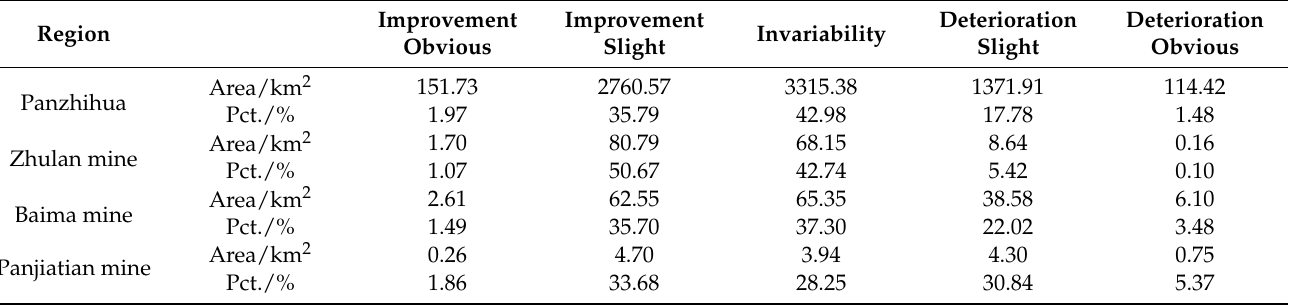
Table 3. Detection of Changes in RSEI Levels